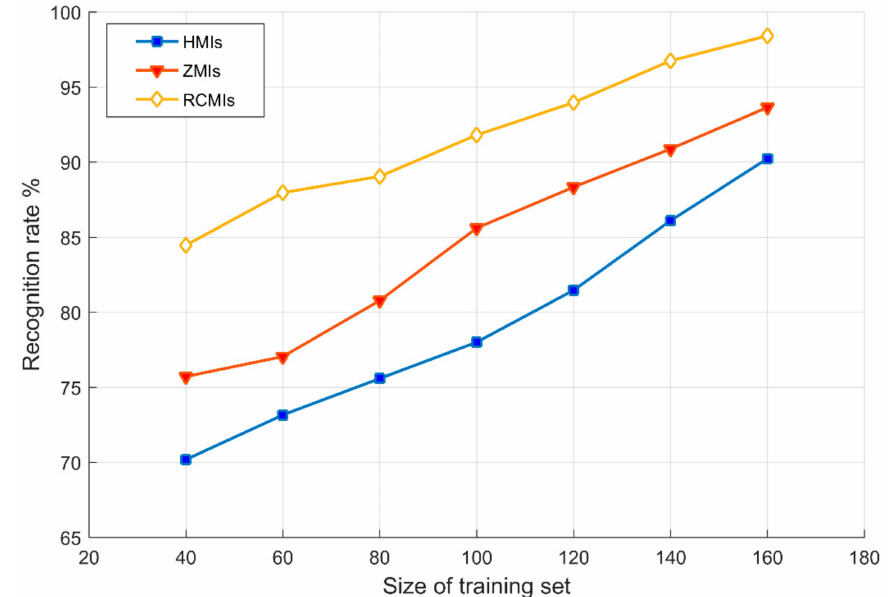
Figure 7. Effect of changing in size of training set in the third case